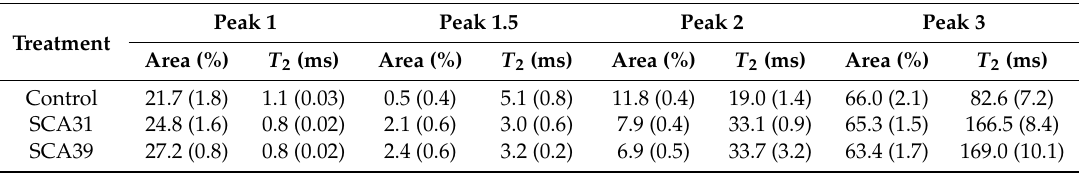
Table 4. Peak maximum T 2 values and non-freezing moisture content for control, 31% sorbitol citric acid and 39% sorbitol citric acid modified samples measured at − 22 °C. Standard deviation of four replicates in parentheses.